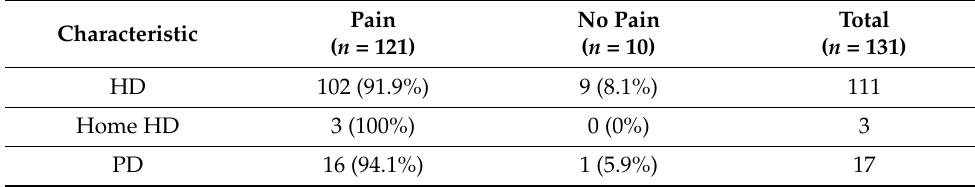
Table 3. Prevalence of pain in each treatment